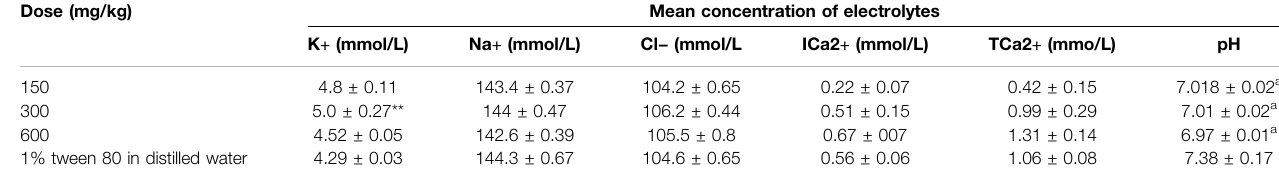
TABLE 3 | Mean levels of electrolytes after 28 days at different doses of the extract. Dose (mg/kg) Mean concentration of electrolytes